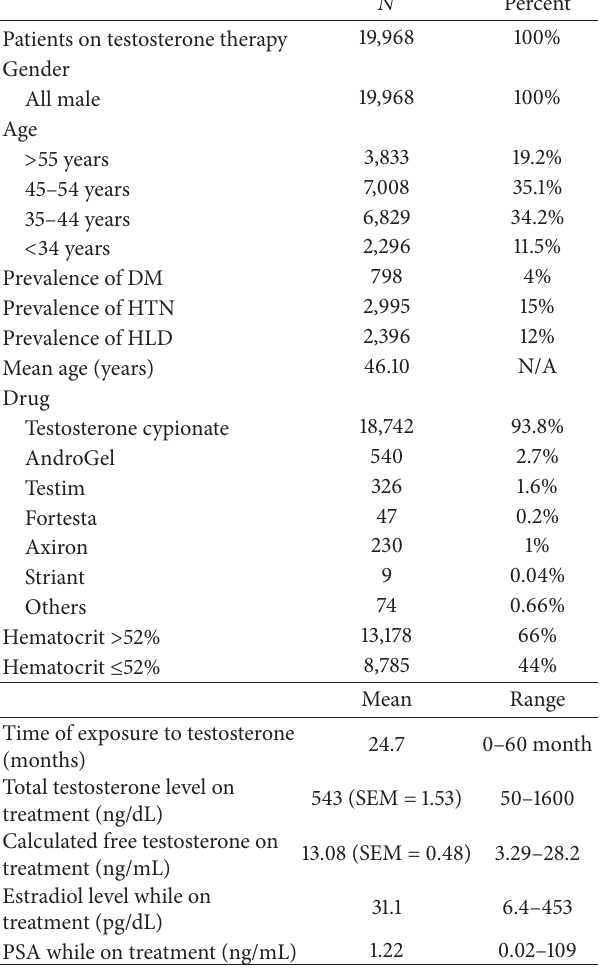
Table 3: Characteristics of study population from Low Testosterone (T)